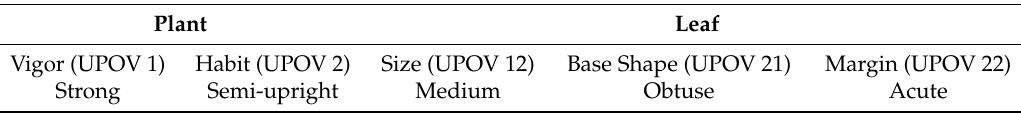
Table 1. Morphological plant characteristics according to the criteria classified by the International Union for the Protection of New Varieties of Plants (UPOV)